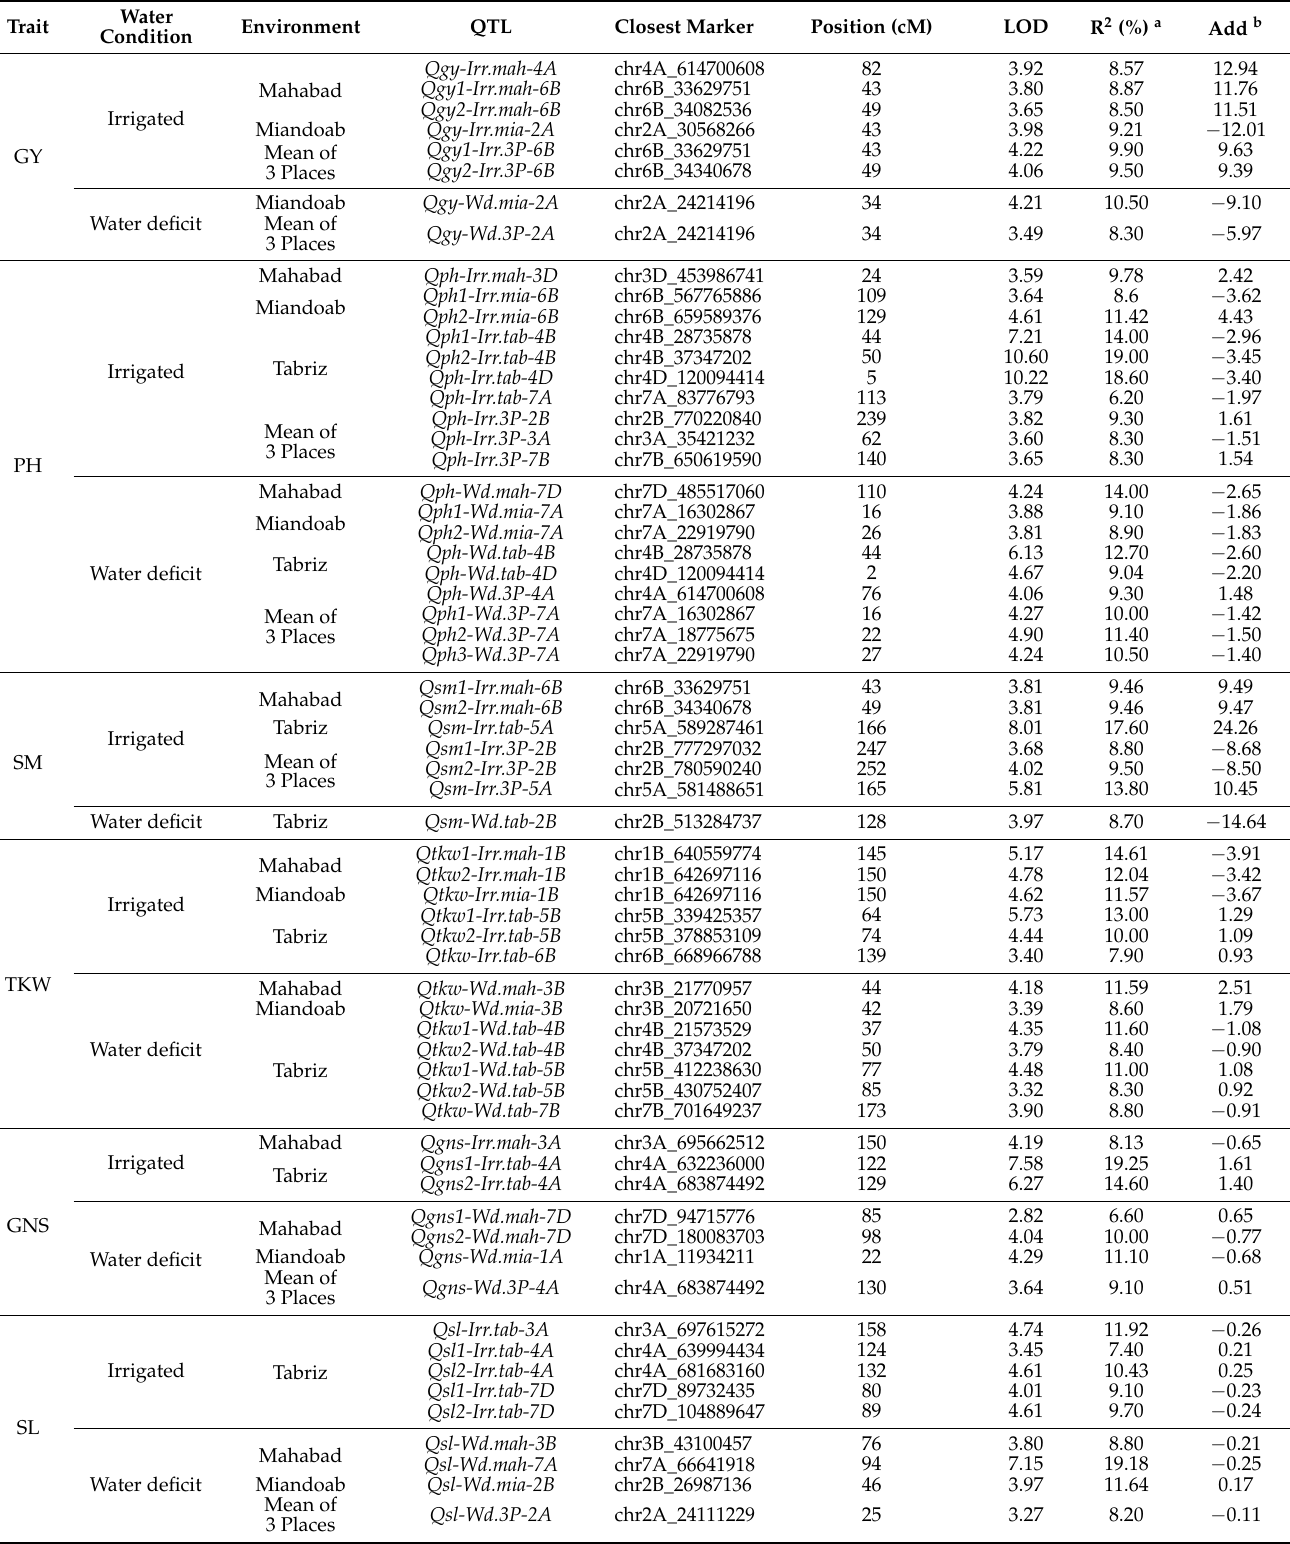
Table 3. List of significant QTL detected for grain yield (GY), plant height (PH), spike number per squared meters (SM), thousand kernel weight (TKW), grain number per spike (GNS), spike length (SL), biomass (BIO), and harvest index (HI) in the Iran #49 × Yecora Rojo RIL population under irrigated and water deficit